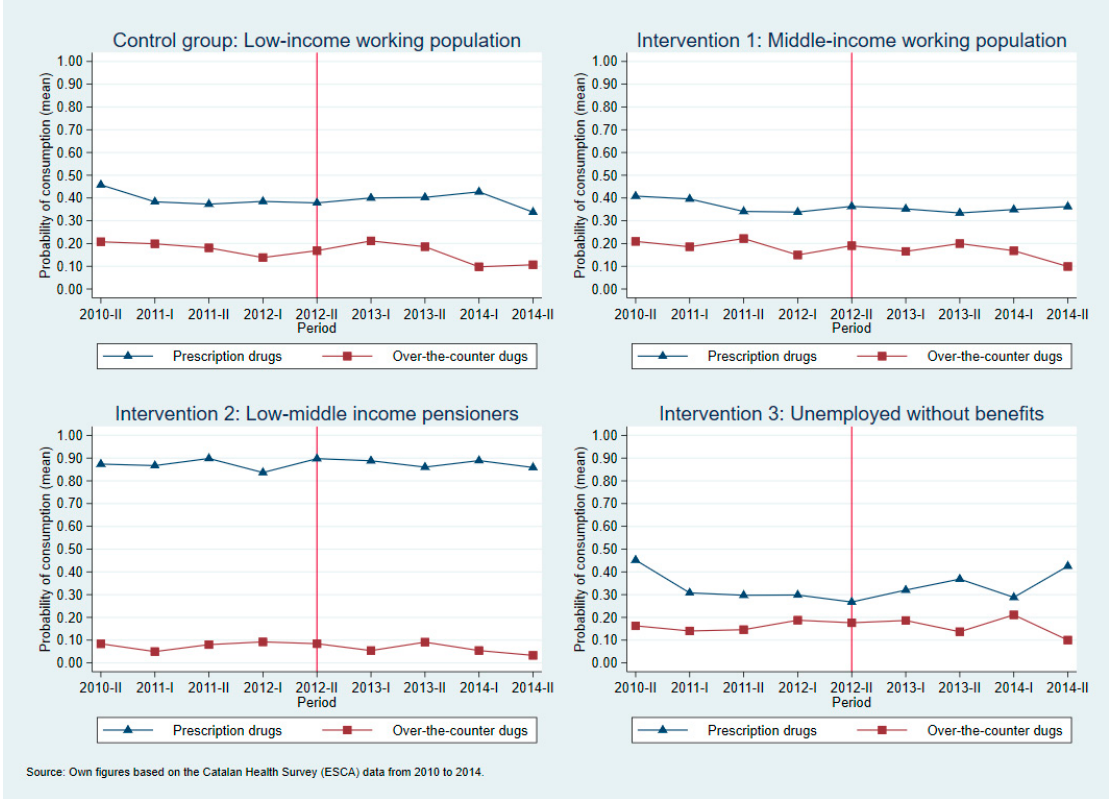
Figure A1. Trends of average propensities to consume medicines during the study period by intervention